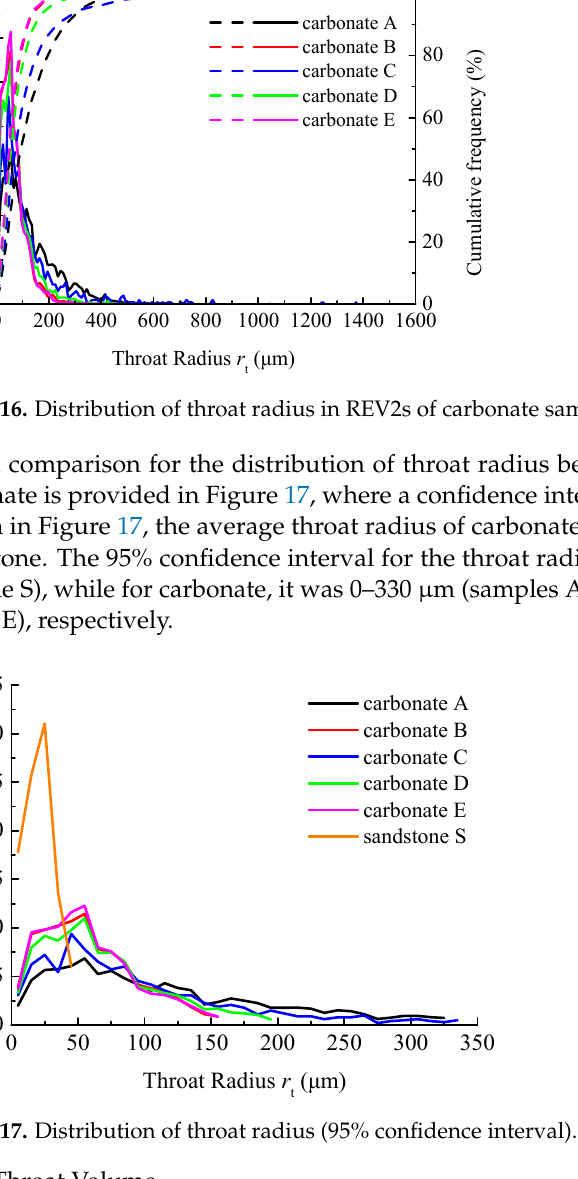
Figure 17. Distribution of throat radius (95% confidence